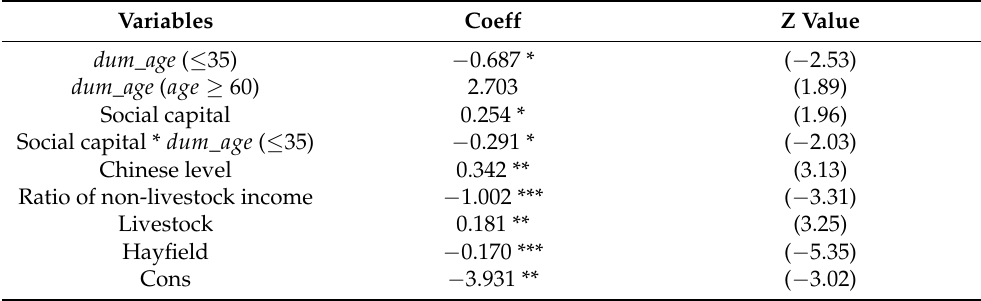
Table A2. Results of the Probit model evaluation and marginal effects without insignificant